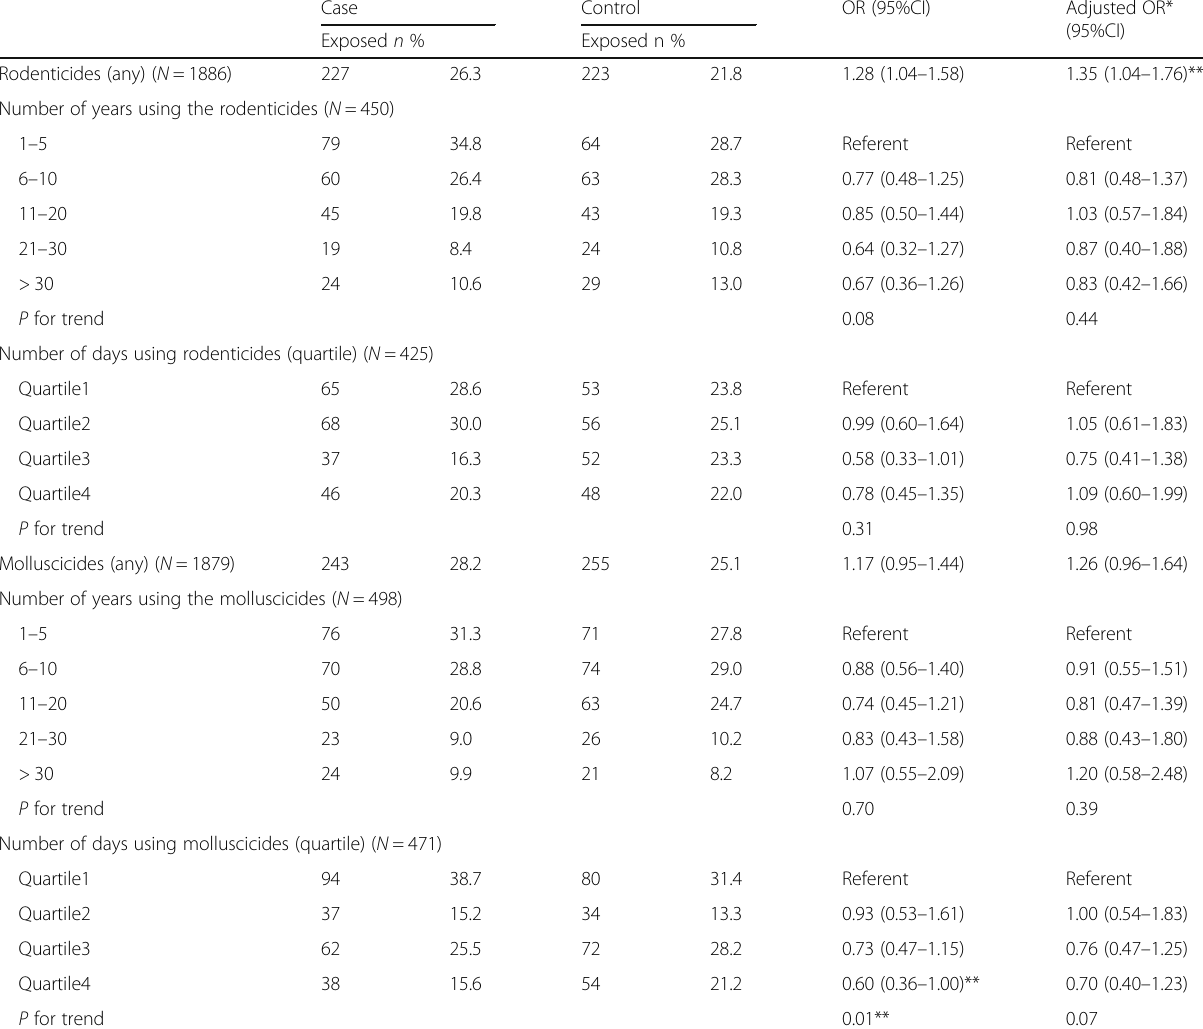
Table 2 Associations between different types of pesticides and diabetes (Continued)